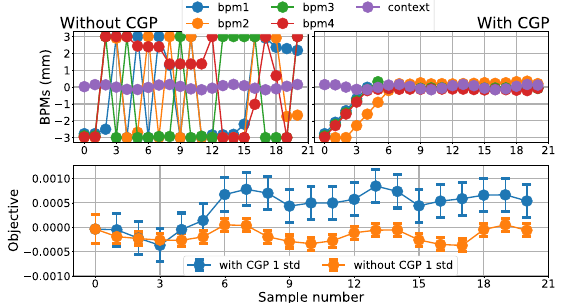
FIG. 15. Physics model-informed BO is used to optimize the contextual objective function. Without the CGP feature (top left), the BO is unable to converge as it cannot correctly model the relationship between the inputs and outputs. Whereas with the CGP modeling the context (top right), the BO successfully handles the dynamic environmental factors and is able to find the optimum